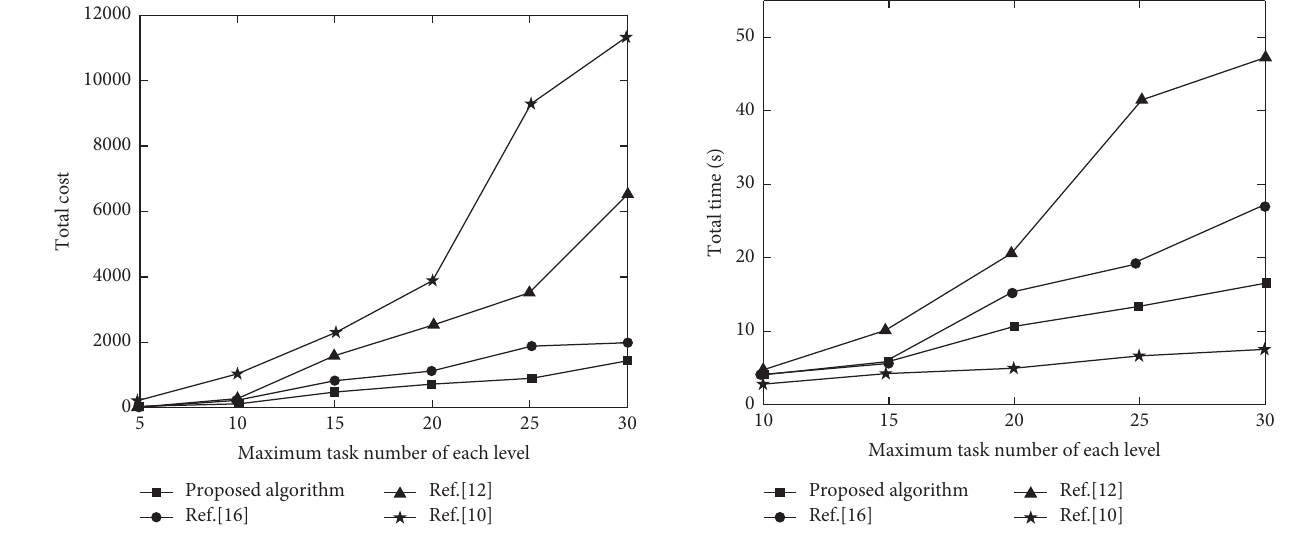
Figure 4: Effect of the number of tasks on total cost. Figure 5: Effect of the number of tasks on total